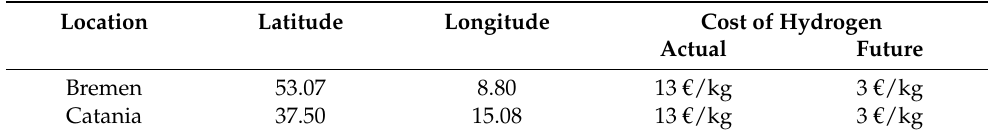
Table 1. Cost of fuel and geo-locations for the simulated scenario. Location